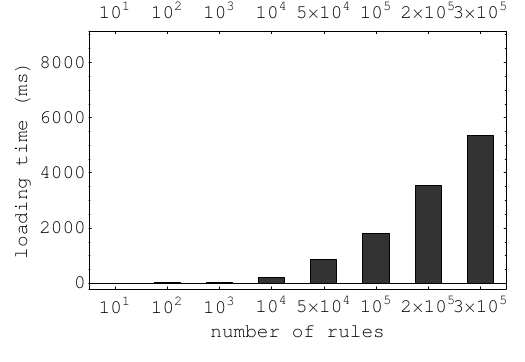
Figure 9. Time of rule